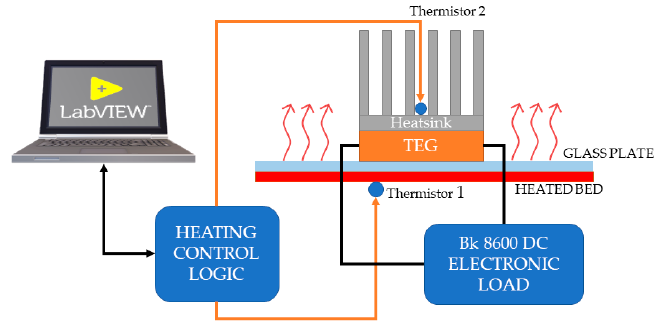
Figure 2. Block scheme of the test platform.